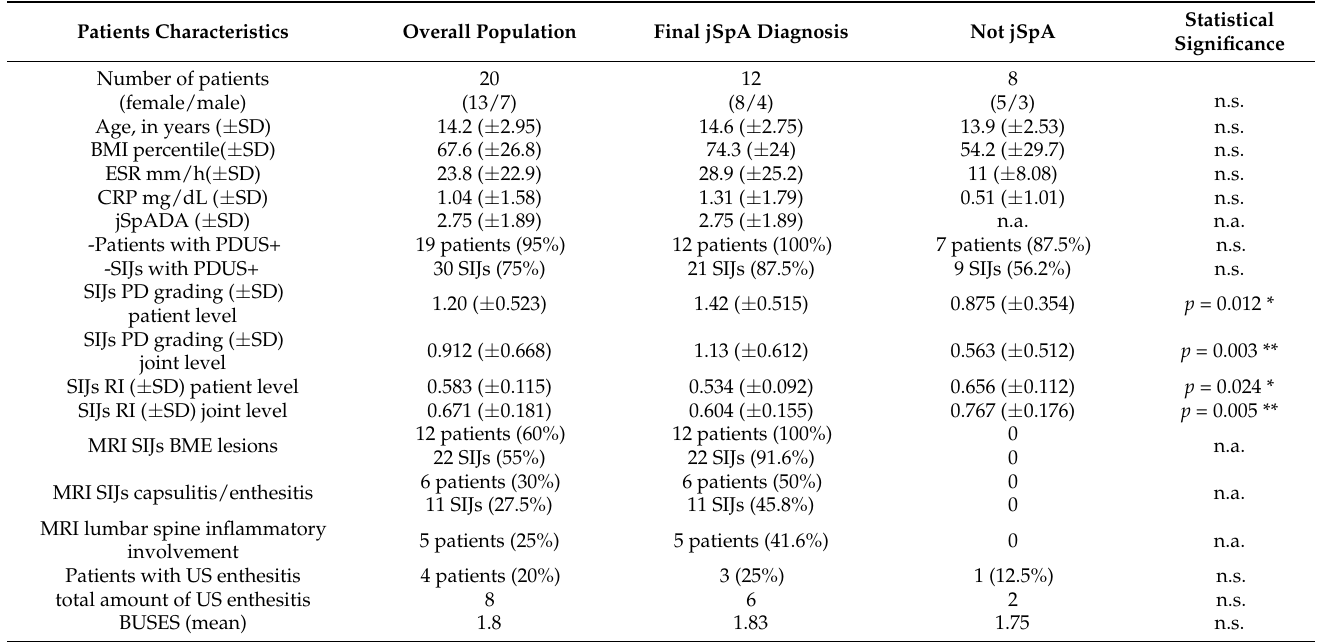
Table 1. Demographic, anthropometric, and clinical characteristics of patients. Data are expressed as mean ( ± standard deviation, SD), if not otherwise specified. The level of statistical significance was set at a p -level of 0.05. n.s. = not significant; * = p < 0.05; ** = p < 0.01; n.a. = not assessed. IBP = inflammatory back pain; jSpA = juvenile spondyloarthritis; PDUS = power Doppler ultrasound; BMI = body mass index; ESR = erytrosedimentation rate; CRP = C-reactive protein; JSpADA = juvenile spondyloarthritis disease activity; SIJ = sacroiliac joint; RI = resistive index; BME = bone marrow edema; BUSES = Belgrade Ultrasound Enthesitis